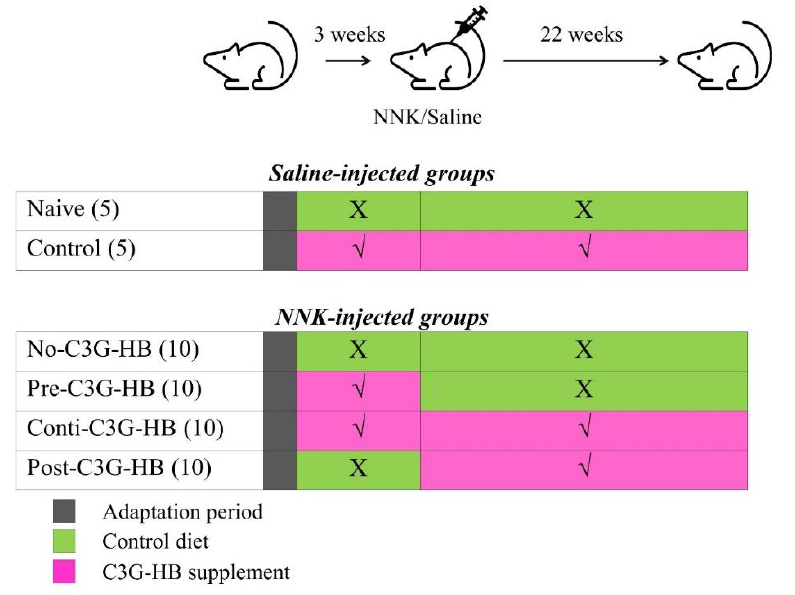
Figure 5. Experimental protocol for investigating the chemopreventive ability of C3G-HB in NNK-induced lung tumorigenesis in A / JCr mice. NNK (100 mg / kg body weight / mouse) or saline was injected three weeks after the adaptation period; n = 5 in saline-injected groups, naive and control, and n = 10 in NNK-injected groups (no-C3G-HB, pre-C3G-HB, conti.-C3G-HB and post-C3G-HB). No-C3G-HB, not given C3G-HB supplemented diet; Pre-C3G-HB, C3G-HB supplemented diet only before NNK injection; Conti.-C3G-HB, C3G-HB supplemented diet continuously before and after NNK injection; Post-C3G-HB, C3G-HB supplemented diet only after NNK injection.